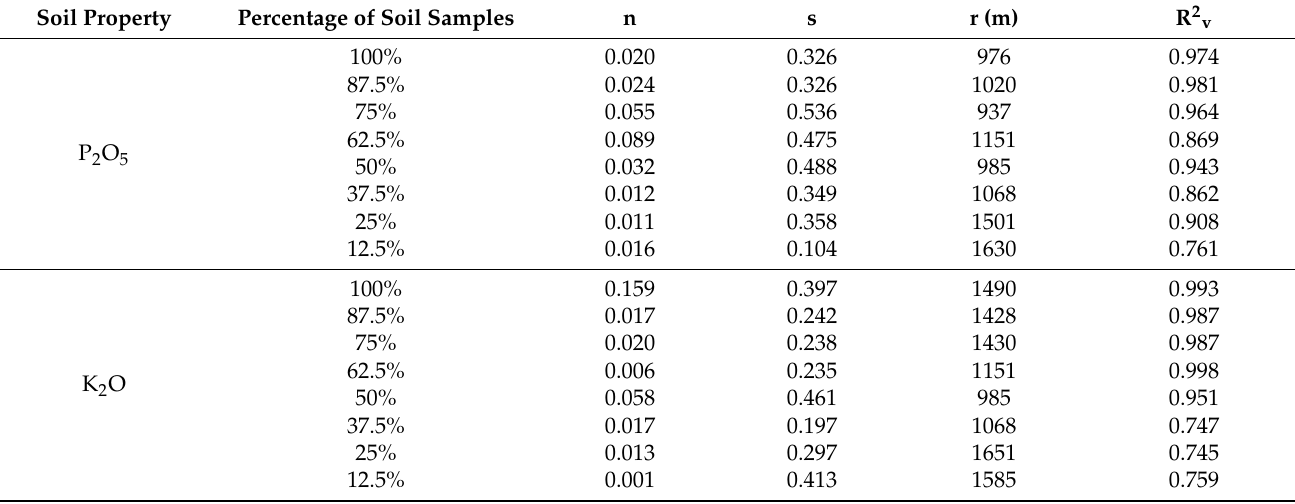
Table A1. OK interpolation parameters for mathematical models with the highest coefficient of determination with variogram per input data